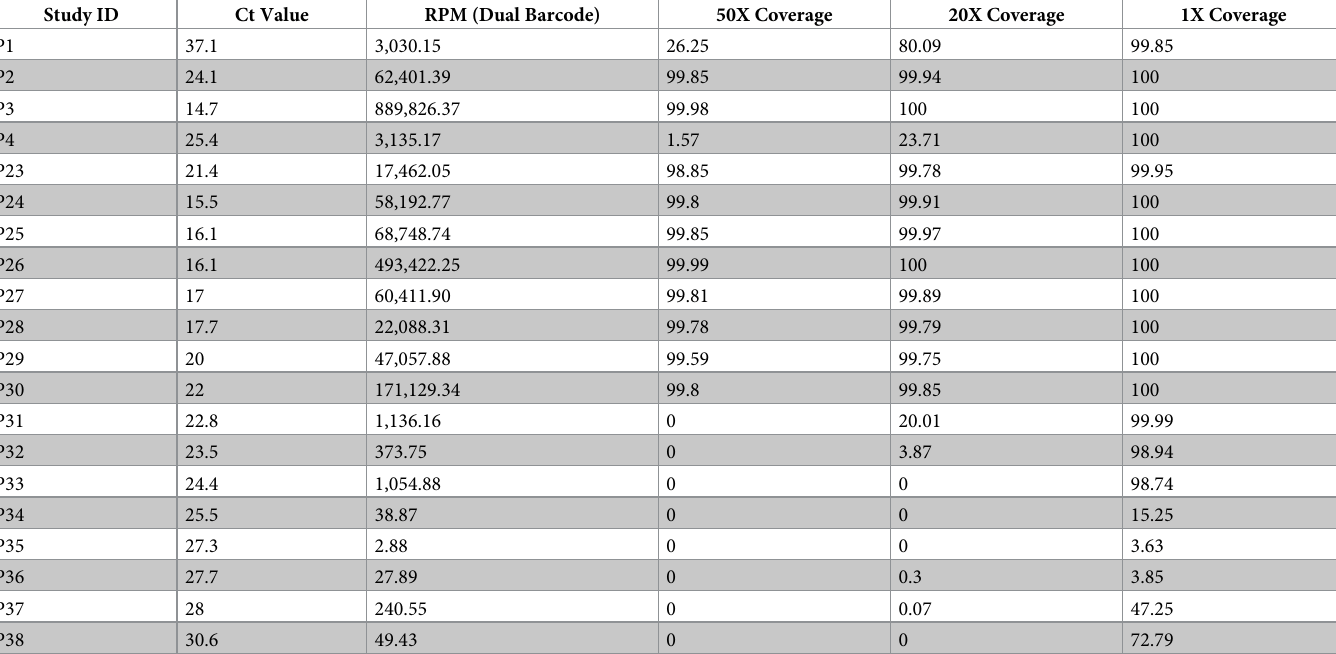
Table 4. Percent SARS-CoV-2 genome coverage for samples classified as mNGS SARS-CoV-2 positive following 0.2% crosstalk